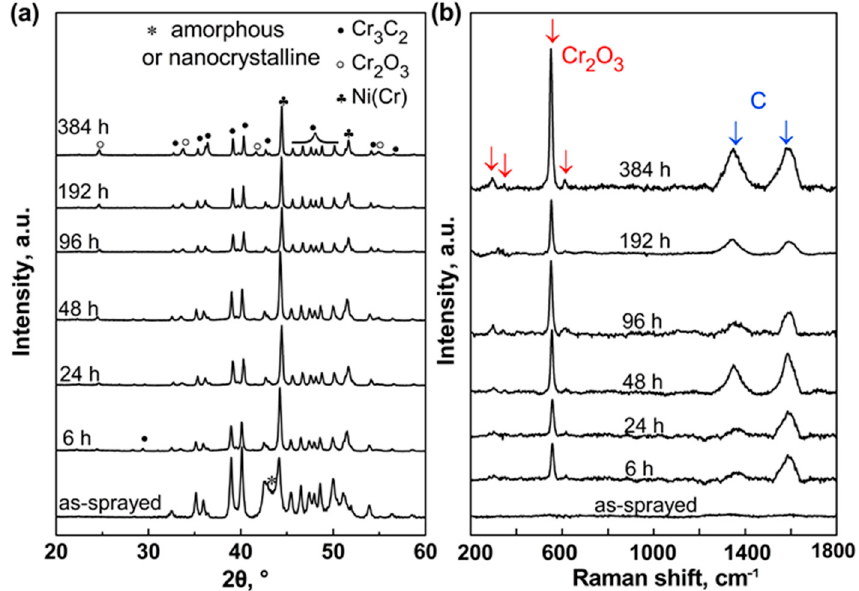
Figure 2. ( a ) X-ray diffraction patterns and ( b ) Raman spectra collected from top surfaces of as-sprayed and annealed coatings.